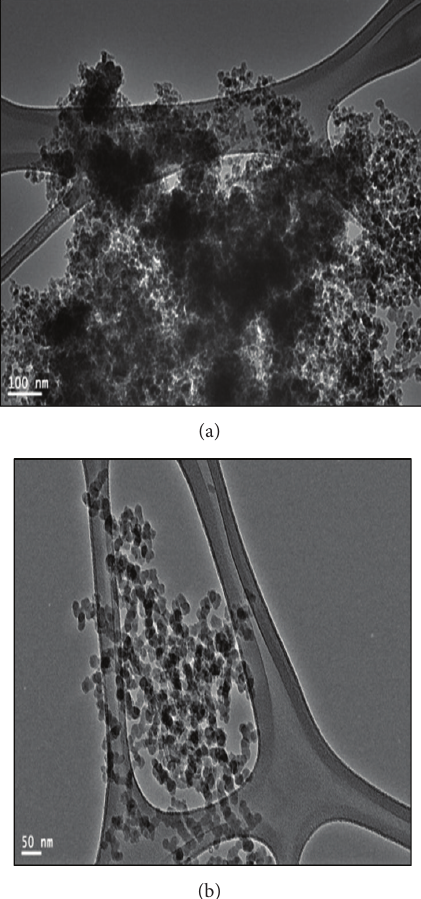
Figure 2: The TEM images of PM 597/SiO 2 core/shell NPs at different